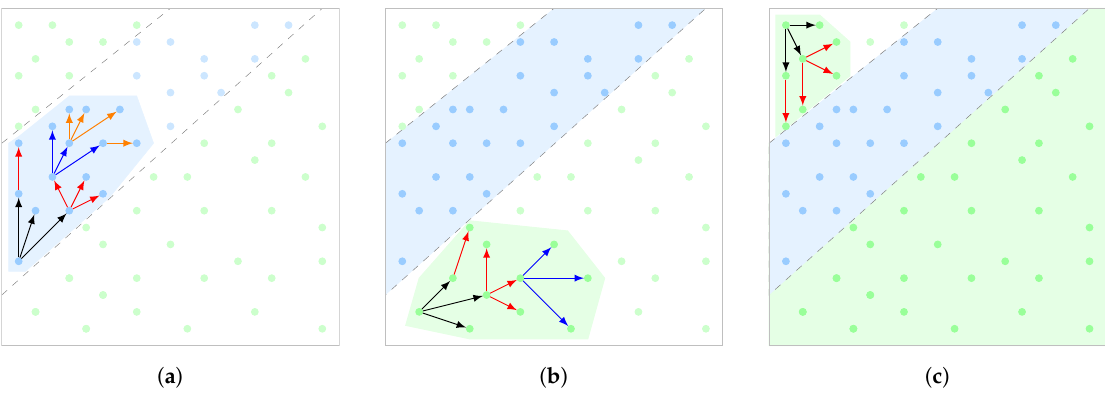
Figure 12. Illustration of the color based region growing segmentation. ( a ) initial segment detection and growing; ( b ) similar point colors detection; ( c ) complete point cloud.